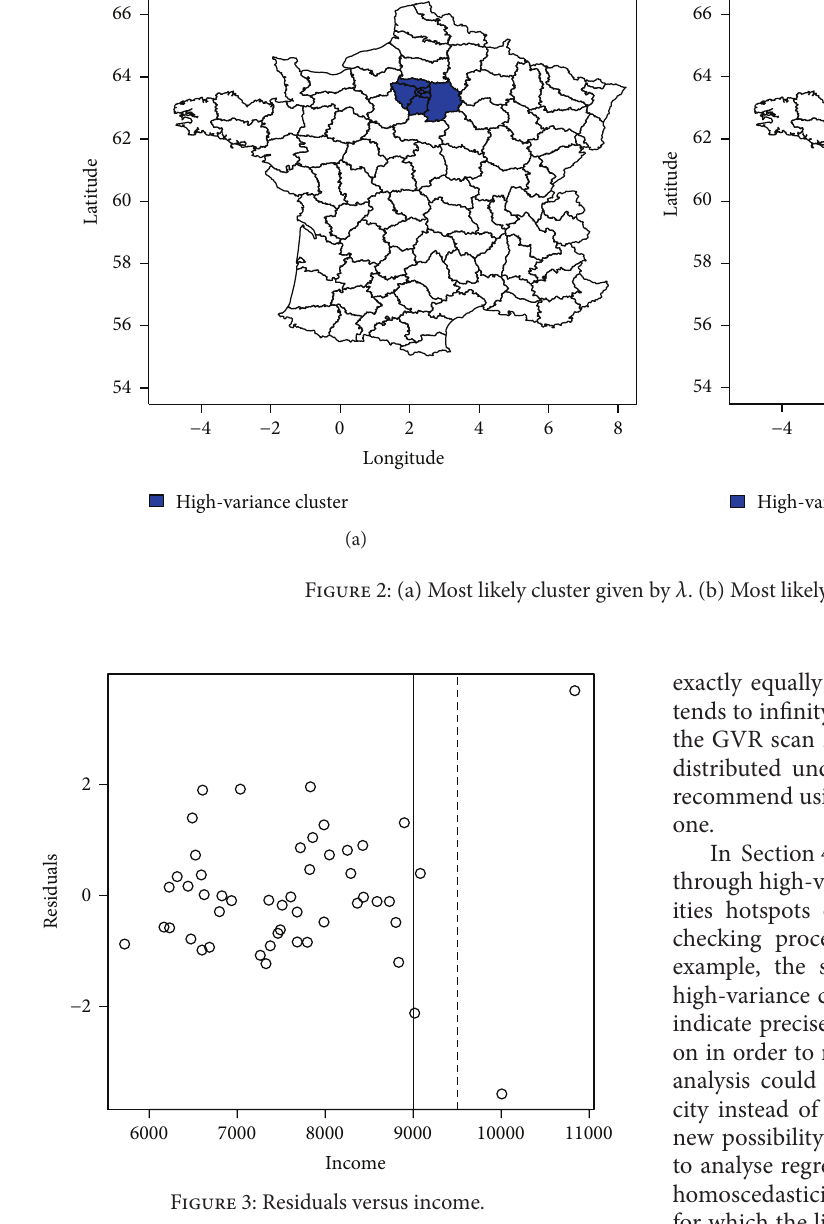
Figure 3: Residuals versus